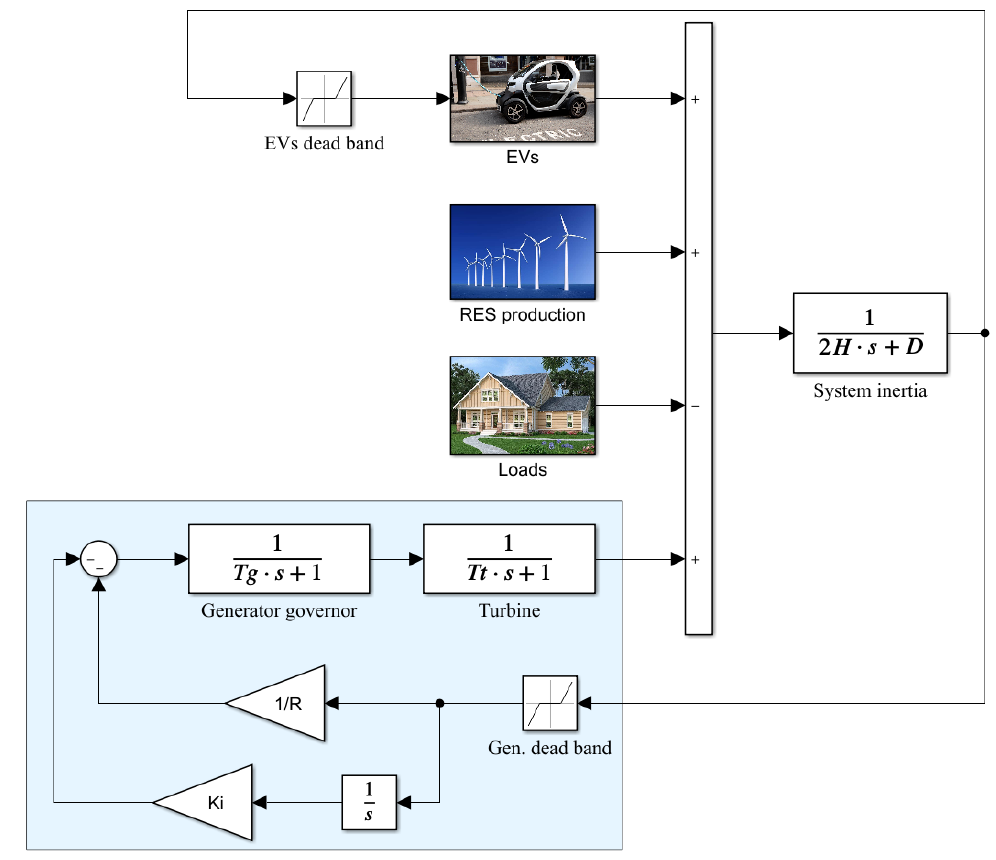
Figure 6. Power system model